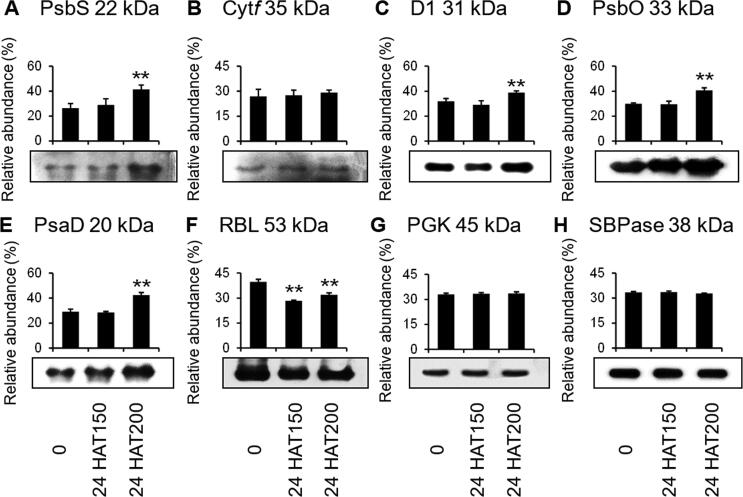
Validation of eight alkali-responsive chloroplast proteins with immunoblottingEight chloroplast proteins from plants under different treatment conditions [0 mM, 150 mM for 24 h (24 HAT150), and 24 HAT200] were loaded with equal amounts. A. Photosystem II 22 kDa protein (PsbS). B. Cytochrome f (Cyt f). C. Photosystem II D1 protein (D1). D. Oxygen evolving enhancer protein (PsbO). E. Photosystem I reaction center subunit II (PsaD). F. RuBisCO large subunit (RBL). G. Phosphoglycerate kinase (PGK). H. Sedoheptulose-1,7-bisphosphatase (SBPase). Proteins were separated by 15% SDS-PAGE and analyzed by immunoblotting. SBPase was used as loading control. The relative abundances of each protein was calculated by comparing the gray value of each lane to the sum of the gray values of all three samples, and result was shown as the average of three independent experiments.